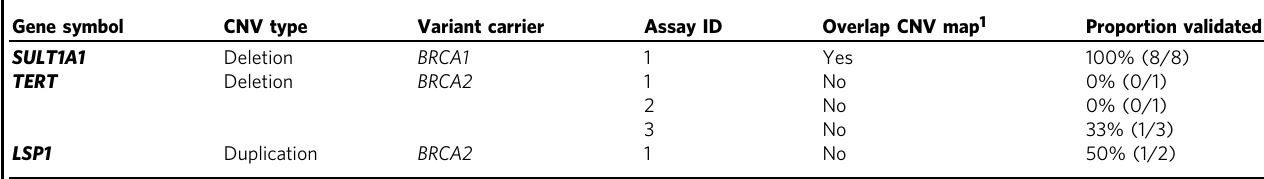
Table 2 Putative copy number variants assessed by TaqMan